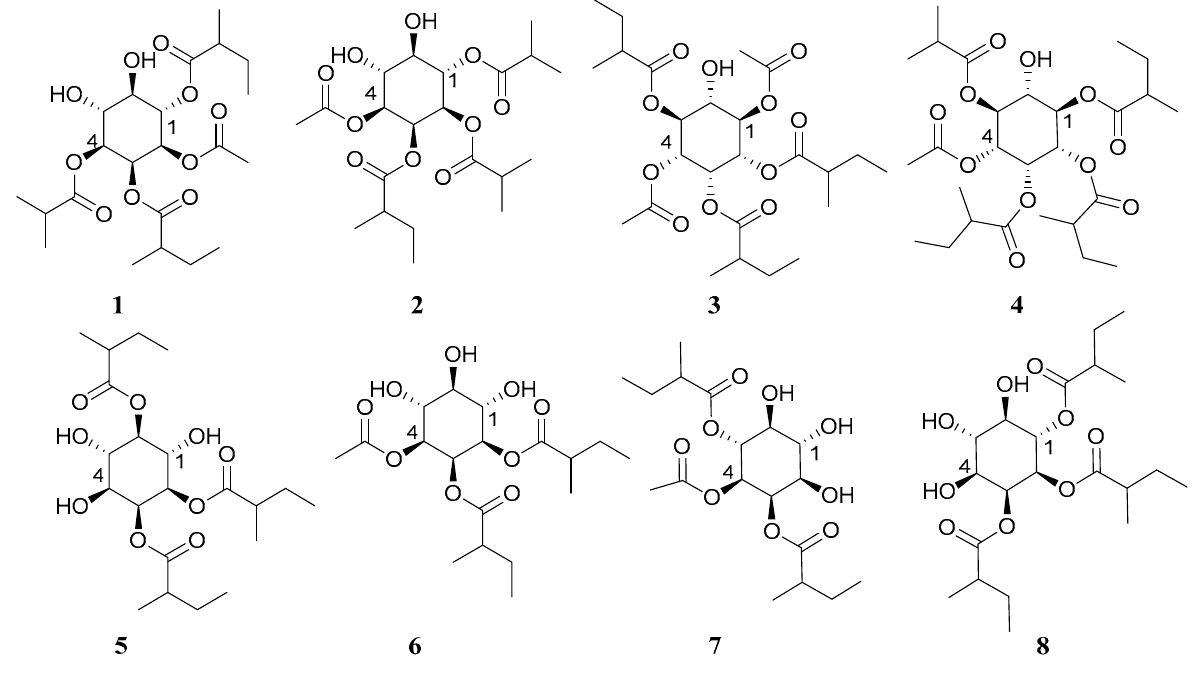
Figure 1. Chemical structures of compounds 1 – 8 .